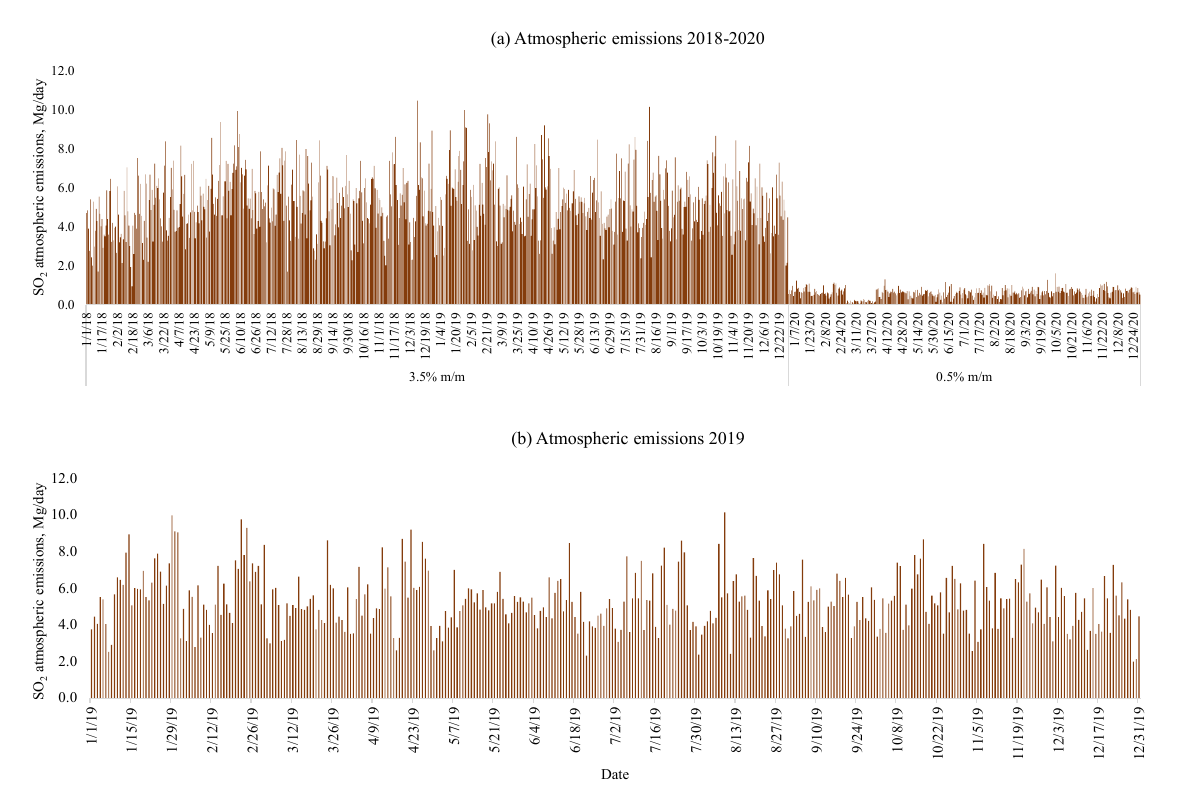
Figure 5. Temporal SO 2 atmospheric emissions by day for ( a ) 2018 to 2020, and ( b ) 2019.